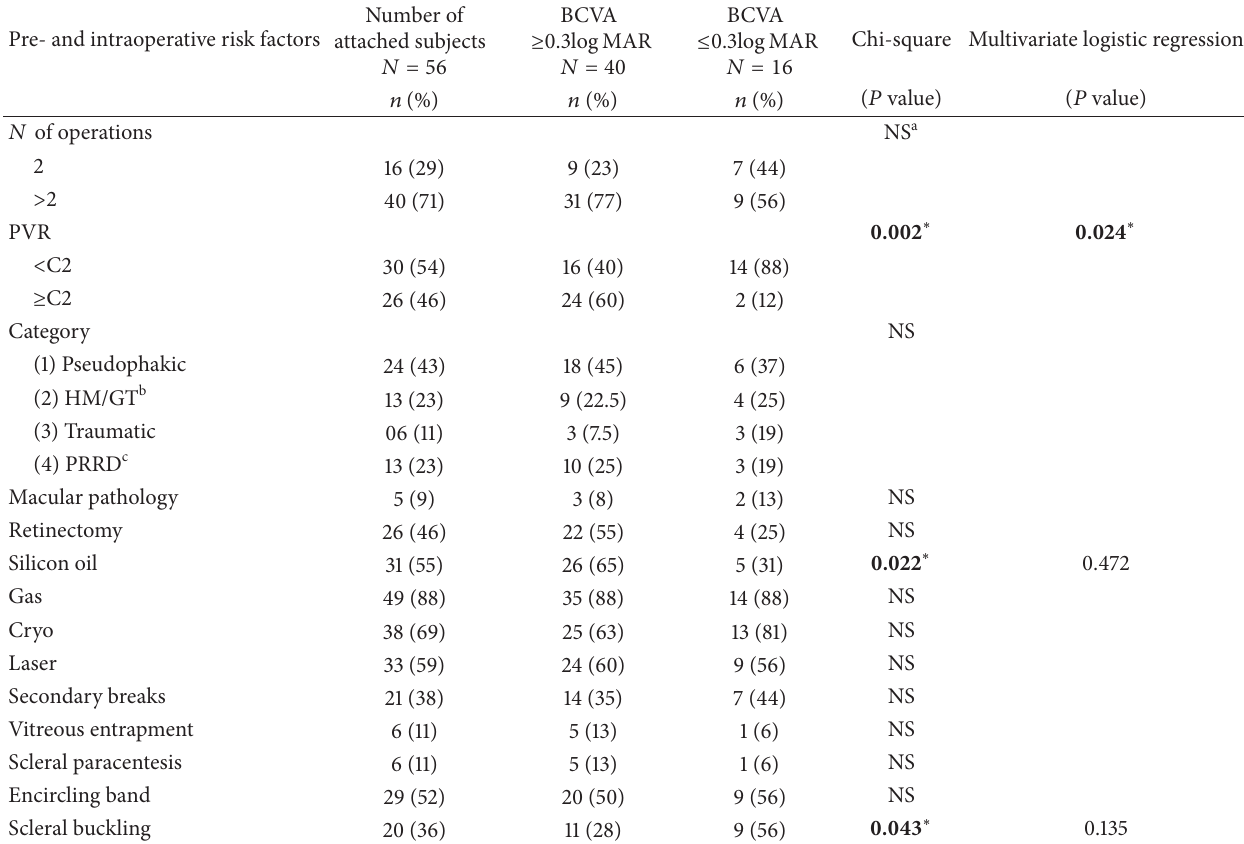
Table 3: Pre- and intraoperative factors affecting the BCVA in the anatomically successful